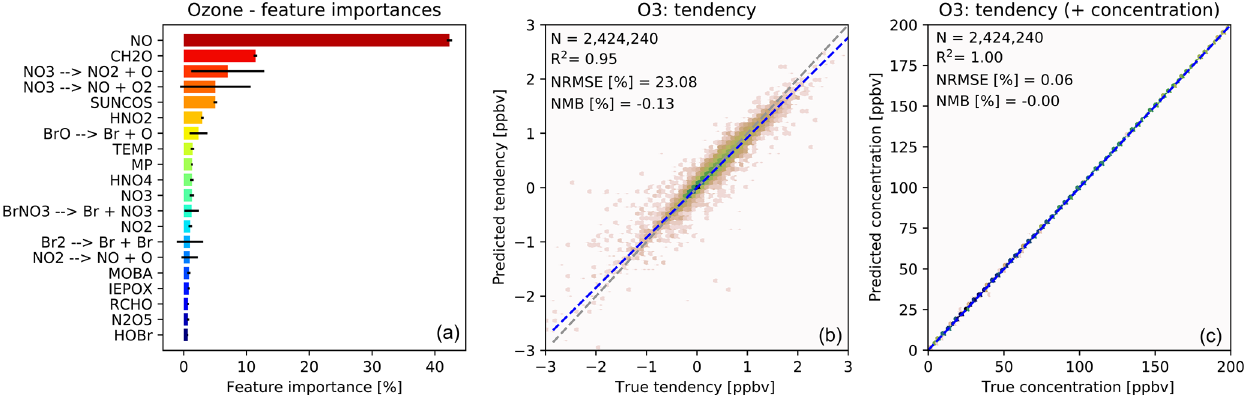
Figure 3. Characteristics of random forest trained to predict tendencies of O 3 due to chemistry. (a) Importance of input variables (features) for random forests trained to predict tendency of ozone due to chemistry. Shown are the 20 most important features for the entire random forest, as averaged over all 30 decision trees. The black bars indicate the standard deviation for each feature across the 30 decision trees. The arrows indicate photolytic conversion (i.e. NO 3 photolyses to NO 2 plus O). (b) Validation of random forest prediction skill for ozone: comparison of ozone tendency validation data ( x axis) vs. predicted values ( y axis). Number of validation points ( N ), correlation coefficient ( R 2 ), normalized root mean square error (NRMSE) and normalized mean bias (NMB) are given in the inset. (c) Same validation but with tendency added to the concentration before integration.